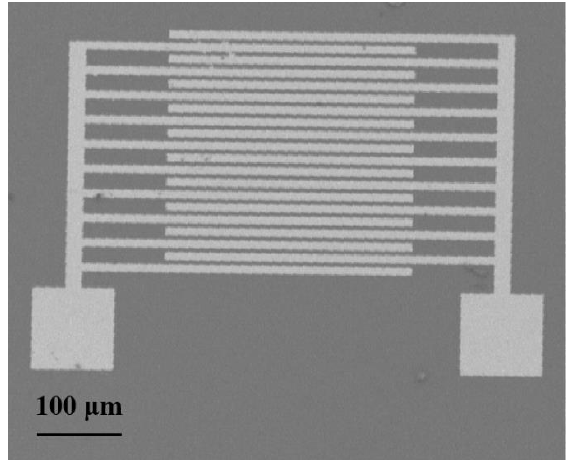
Figure 1. SEM image of the tested device.